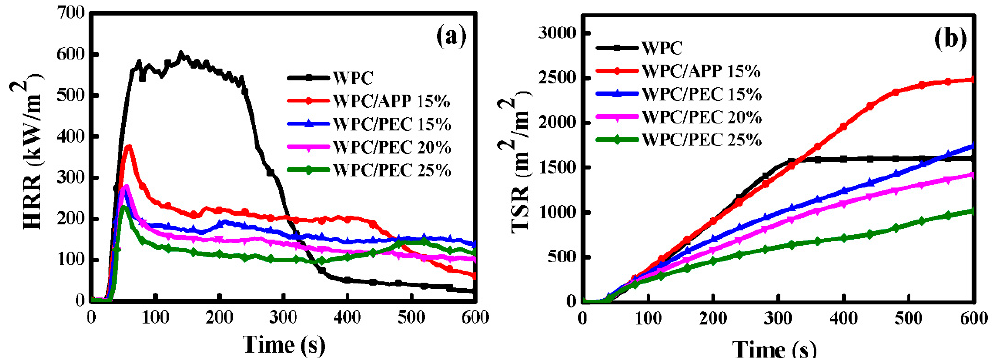
Figure 3. CCT results of WPC with PEC: ( a ) HRR and ( b ) TSR.